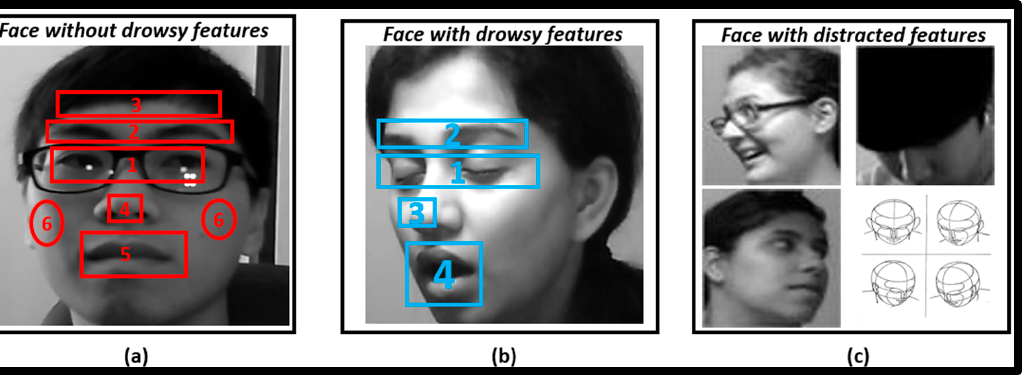
Figure 9. Three of the driver’s state features for database construction. ( a ) Face with 7 points detected, ( b ) face image with 4 points detected and ( c ) face with distracted features.